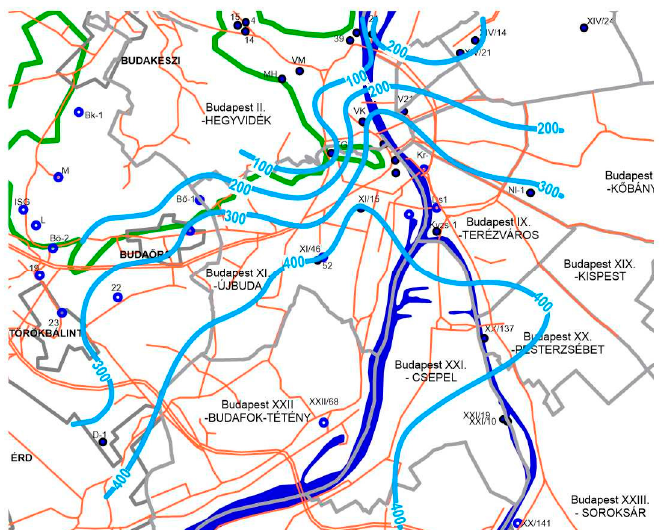
Figure 3. The distribution of the dissolved sulphate (mg/L) in the thermal waters of Budapest. Isolines (light blue) are interpolated from the point data by manual interpretation based on linear estimation (Á. Lorberer co-author). Key: blue dots—measured karst wells; blue circles—other karst wells having SO 4 -measurements; green lines—border between the unconfined mountainous part and the confined thermal part of the aquifer; grey lines—district and city borders; orange lines—main roads.